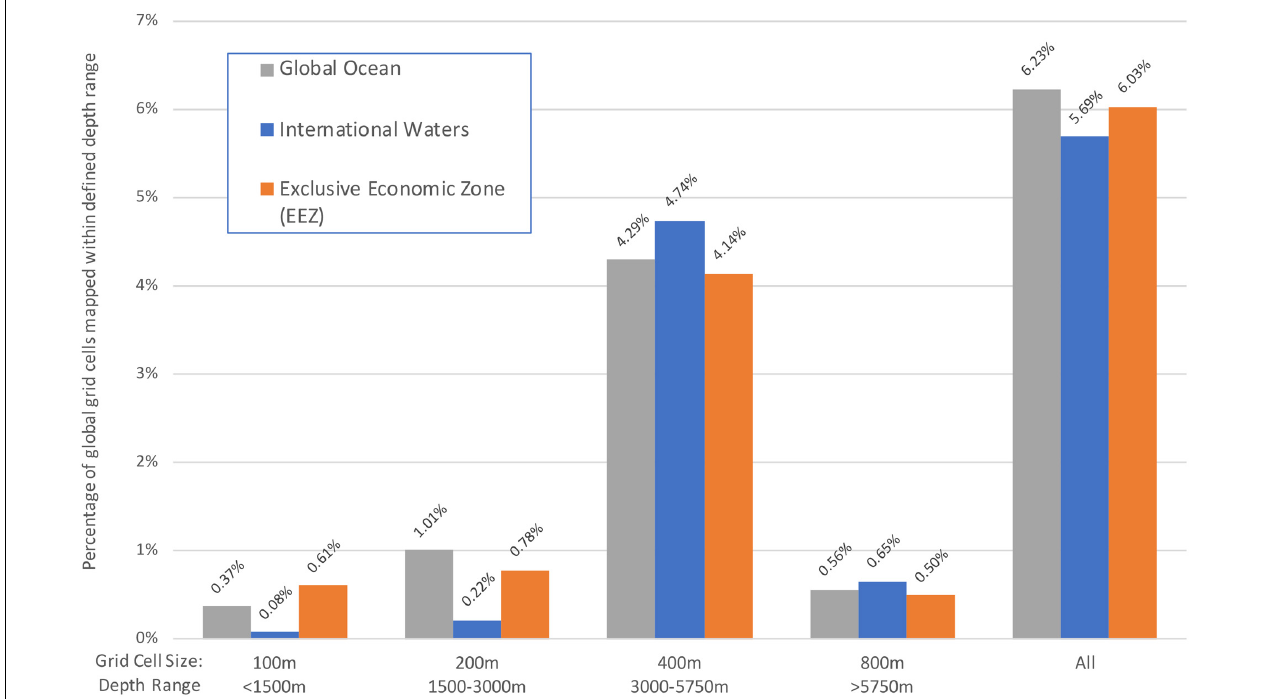
FIGURE 8 | Percentage of the Seabed 2030 target depth-dependent resolution global grid that would be considered “mapped” using the GEBCO_2014 source data, split by contribution from each depth range: calculated as percentage of grid cells in the global ocean, in international waters and in exclusive economic zones (EEZ; all data in Antarctic waters are considered to be outside countries’